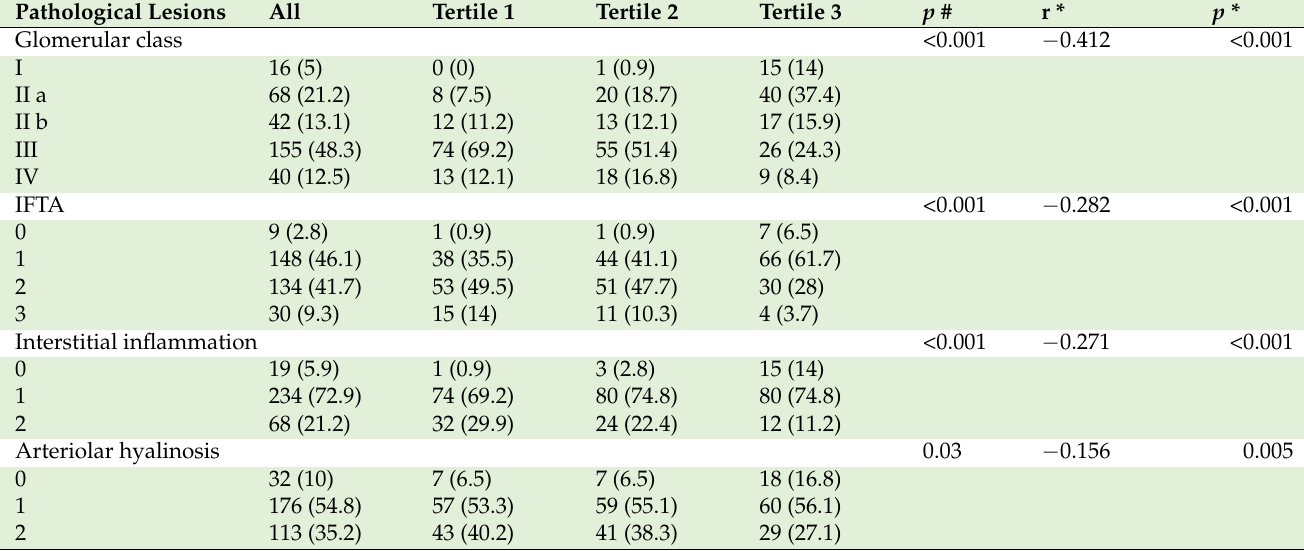
Figure 2. Correlations of prognostic nutritional index (PNI) with ( A ) eGFR, ( B ) urine protein, and ( C ) blood urea nitrogen among patients with diabetic nephropathy. Table 2. Pathologic features of patients with different PNI tertiles.